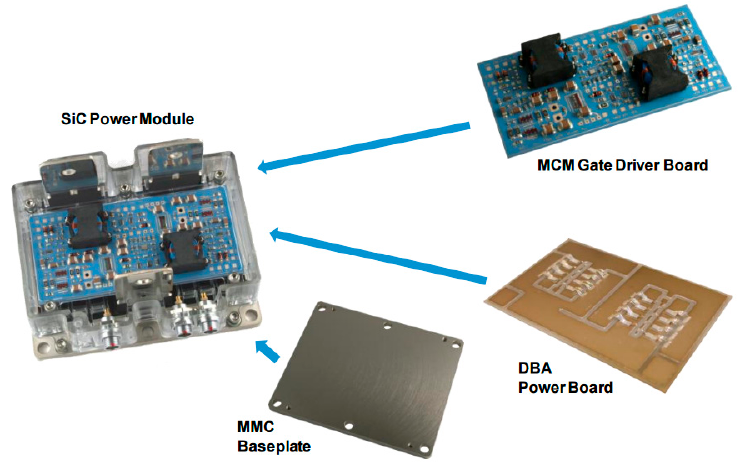
Figure 1. The high temperature half-bridge SiC module [26]. DBA: direct bonded aluminum.